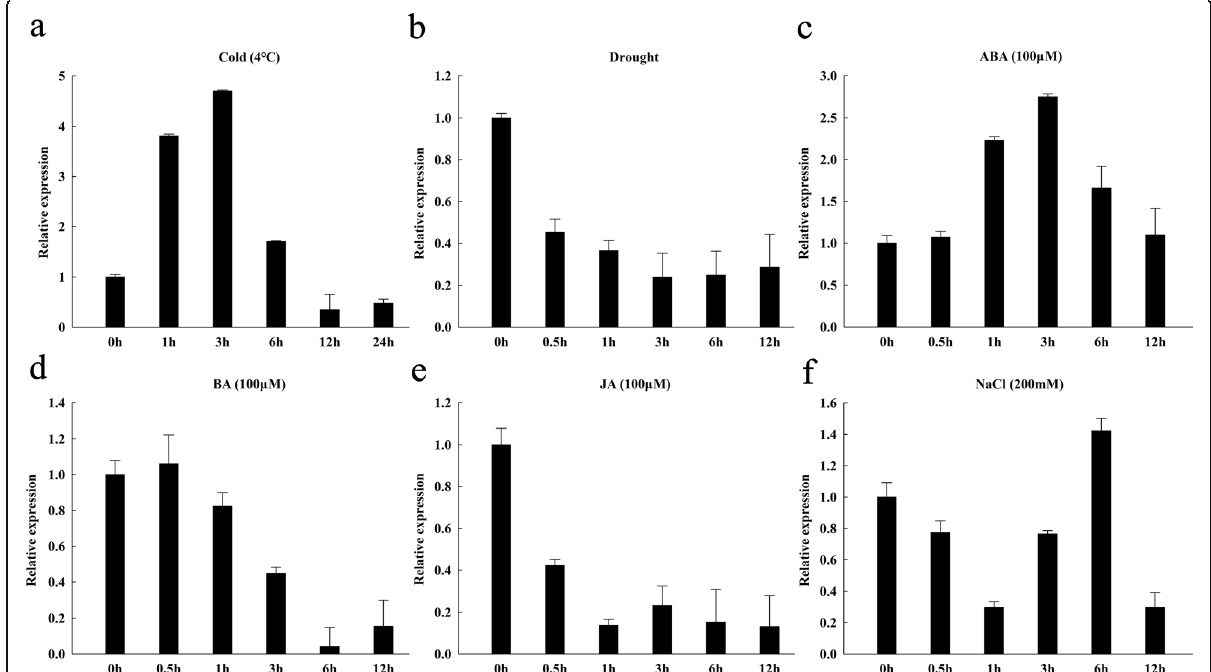
Fig. 2 Time-course expression analysis of OsGATA16 after exposure to abiotic stress or phytohormones. a Cold, b Drought, c Abscisic acid (ABA), d 6-benzylaminopurine (BA), e Jasmonic acid (JA), and f NaCl. Data represent the mean ± SE from three